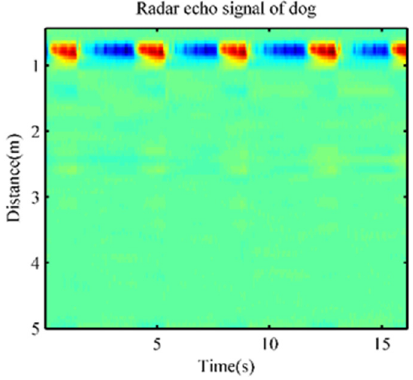
Figure 4. The radar echo signal of the dog.